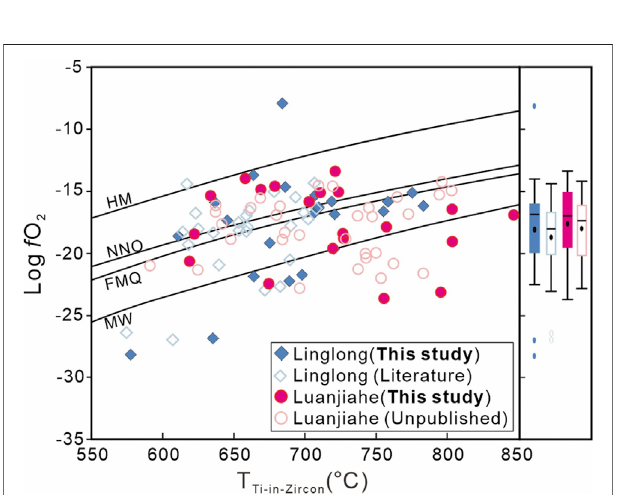
FIGURE 13 | Rb vs Rb/Nb diagram of whole-rockss from the Linglong and Luanjiahe granites, showing a FC-A (Decoupled assimilation-fractional crystallization) model for magma evolution. The “ r ” is the ratio of assimilated material to crystallized material. Details for the FC-A model can be found in Cribb and Barton, (1996). The FC-A modelling was conducted in an Excel © based program of PetroGram (Gündüz and Asan, 2021). The bulk partition coef fi cient (D values) of Rb and Nb between the solid phase (i.e. mineral) and liquid (i.e. melt) was set to 0.1. The interval between F values was 10%. The literature data of Linglong and Luanjiahe granites are from yang et al., 2017 and Yang et al., 2012,